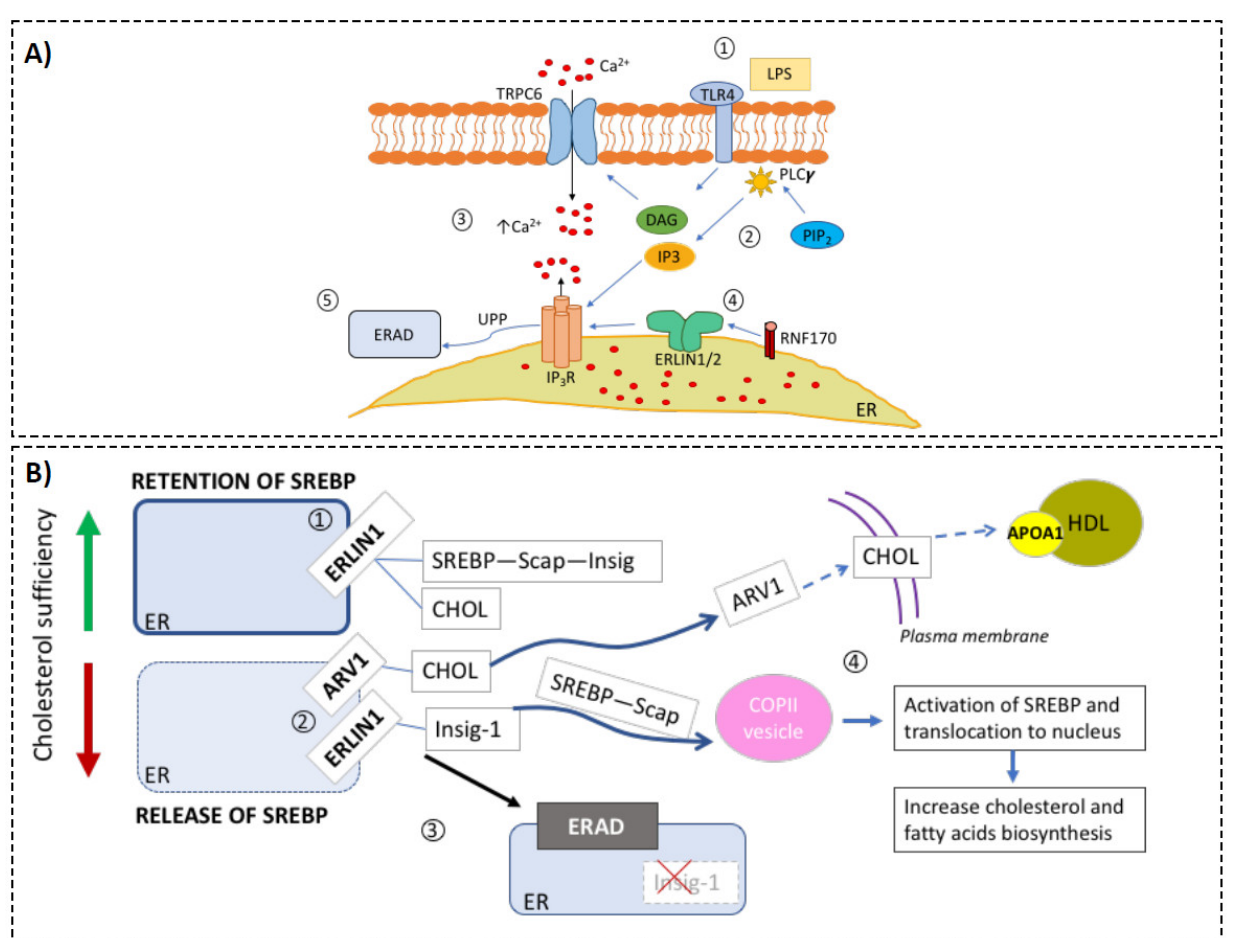
Figure 3. Hypothetical model of the roles of ERLIN1 in cellular metabolic regulation during sepsis. Based on the compen- dium of evidence from public transcriptomic data, scientific literature reports, and our preliminary results, we assembled relevant biological knowledge about the roles of ERLIN1 in calcium and cholesterol regulation. ( Panel A ) ERLIN1-mediated regulation of intracellular Ca 2+ during sepsis: (1) Toll-like receptor 4 (TLR4) is activated by its ligand l LPS; (2) Second messengers, inositol triphosphate (IP3), and diacylglycerol (DAG) are produced via the enzymatic activity of phospholipase-c (PLC γ ); (3) increase in intracellular Ca 2+ due to activation of the transient receptor potential ion channel TRPC6 by DAG, and release of ER pool via the binding of IP3 to the inositol triphosphate receptor (IP 3 R); (4) immediately upon IP3R activation, ERLIN dimer recruits E3 ligase RNF170 [9], and (5) tags the receptor for degradation via ERAD. ( Panel B ) Putative alteration of cholesterol homeostasis during sepsis: (1) ERLIN1 retains cholesterol (CHOL) and the SREBP–SCAP–Insig complex in the ER membrane [7]; (2) SCAP-induced conformation changes during CHOL insufficiency and leads to dissociation of SREBP from ERLIN1. Independently, CHOL is transported to the plasma membrane via the sterol homeostasis protein (ARV1); (3) ERLIN1 tags Insig-1 for degradation, and the SREBP–SCAP complex is released to the Golgi to activate CHOL synthesis. Septic stress could induce ERLIN1 expression to increase ERAD efficiency. Collaterally, this could promote the retention of intracellular cholesterol. Low levels (below 25.1 mg/dL) of high-density lipoprotein cholesterol (HDL-C) have been strongly associated with the risk of adverse outcomes in sepsis